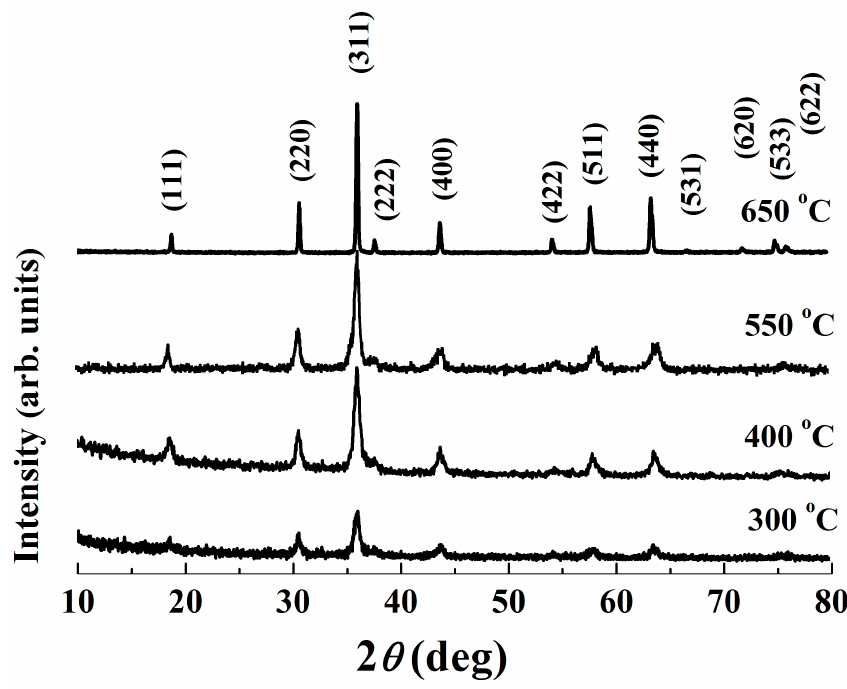
Figure 3. XRD patterns of calcined powders.